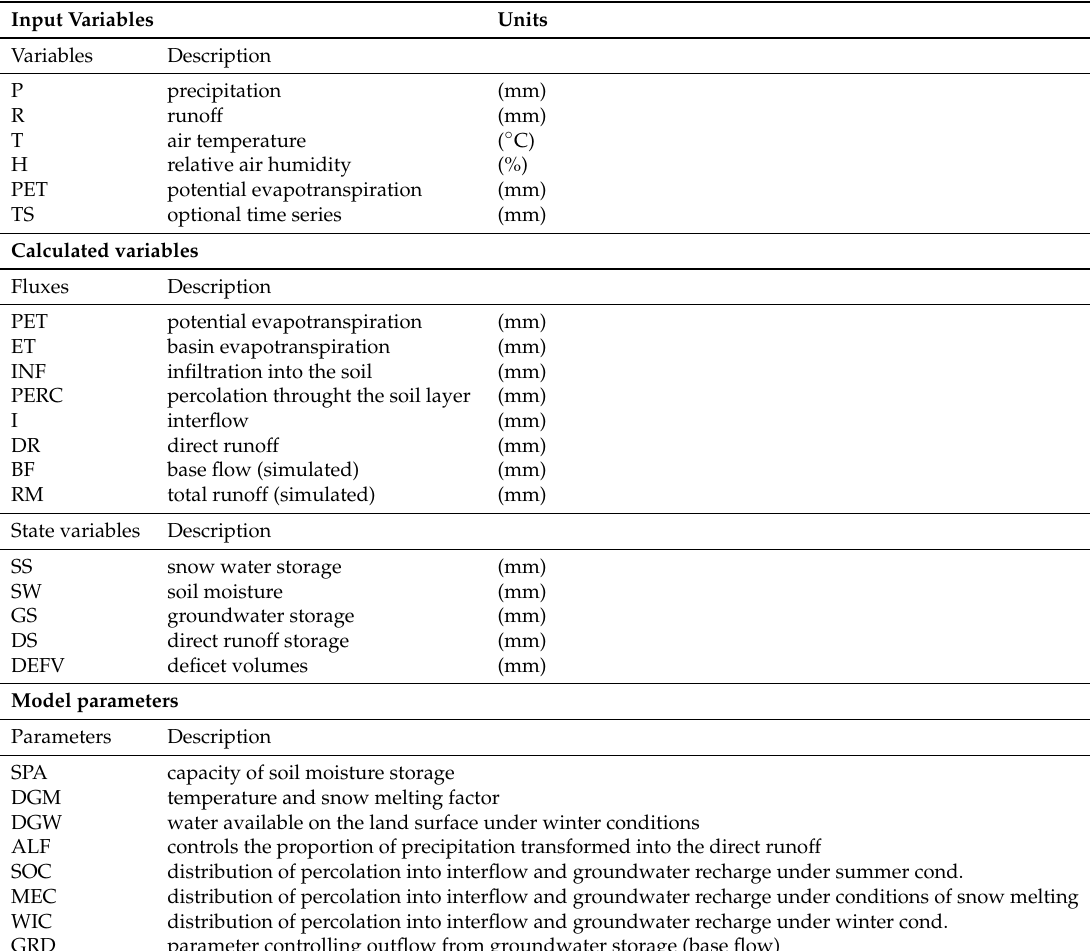
Table 1. Input and output variables and parameters of the Bilan